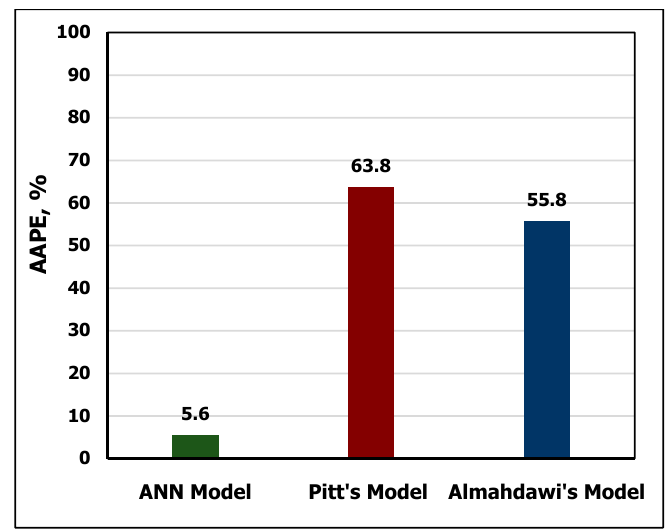
Figure 12. Comparison between the developed (AV) ANN model and the previous approaches.